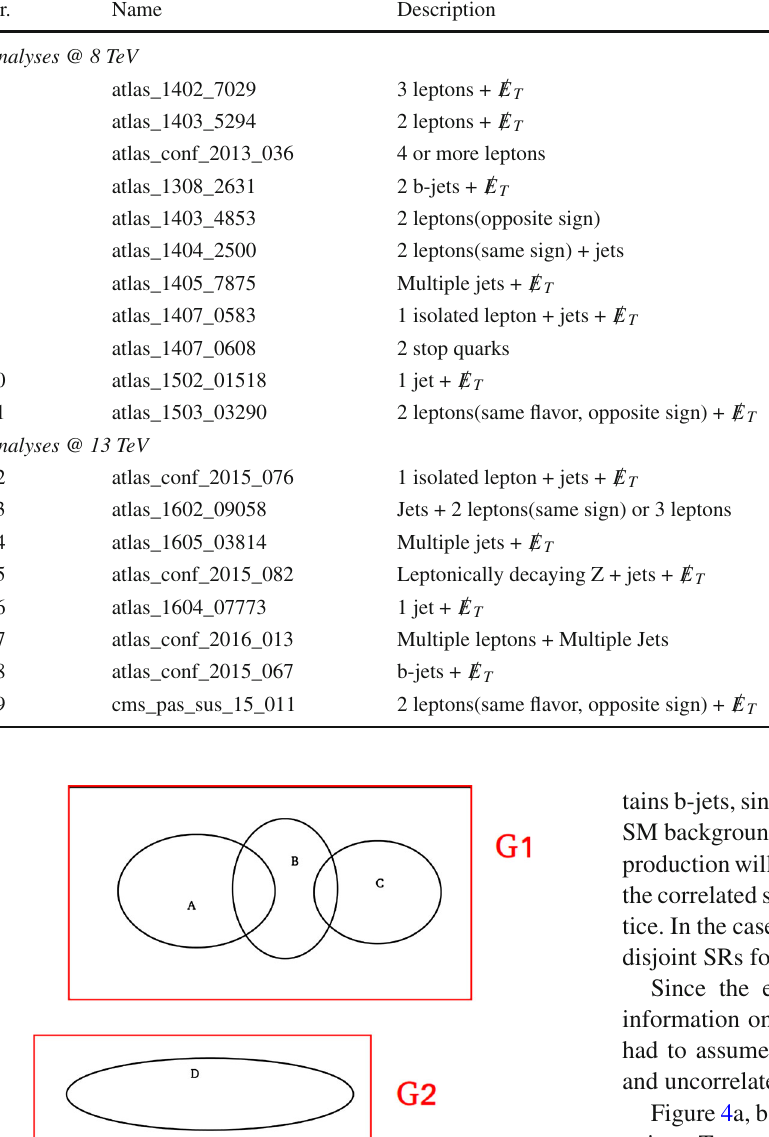
Table 3 Analyses considered at 8 and 13 TeV. The names correspond to the internal CheckMATE nomenclature. L denotes the luminosity and N SR the number of SRs for each analysis Nr.